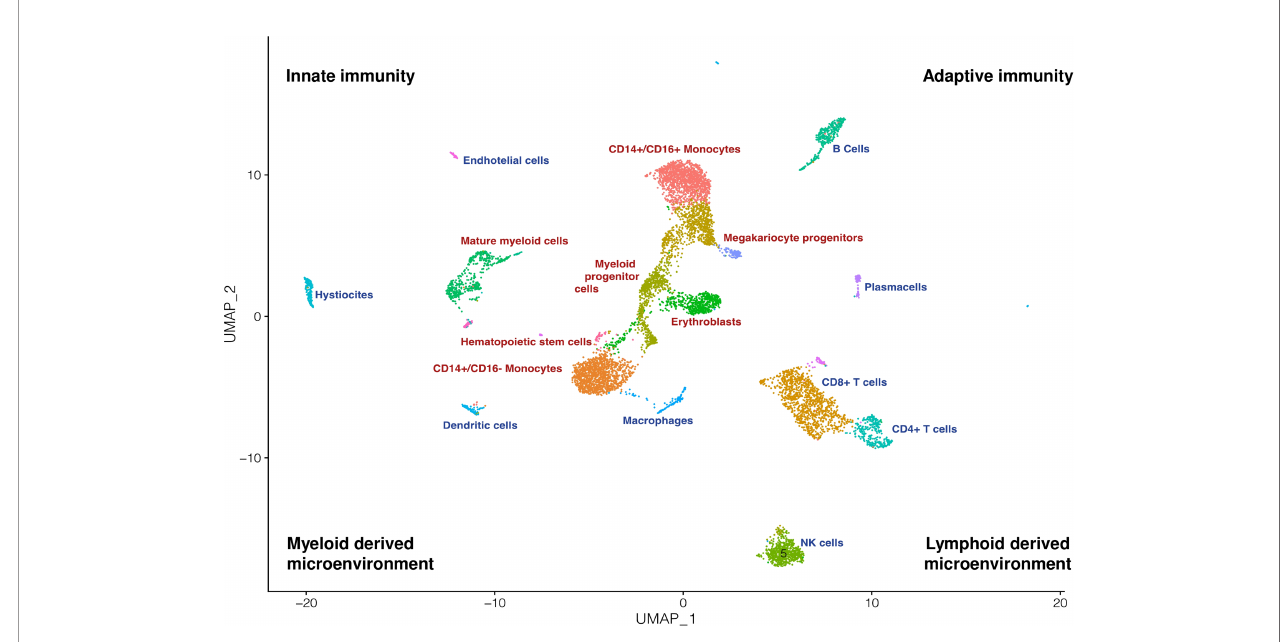
FIGURE 1 | The myeloid compartment and its microenvironment. Bone marrow is a tissue de fi ned by a high cellular and biological complexity. This UMAP recapitulates how myeloid cells (red text) are surrounded and in strict connection with a complex and multifaceted immune microenvironment (blue